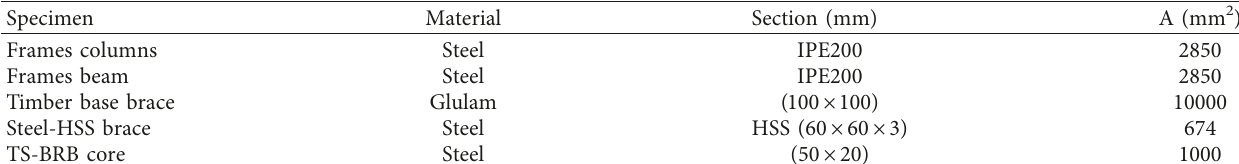
Table 3: Details of the frame and brace specimens.